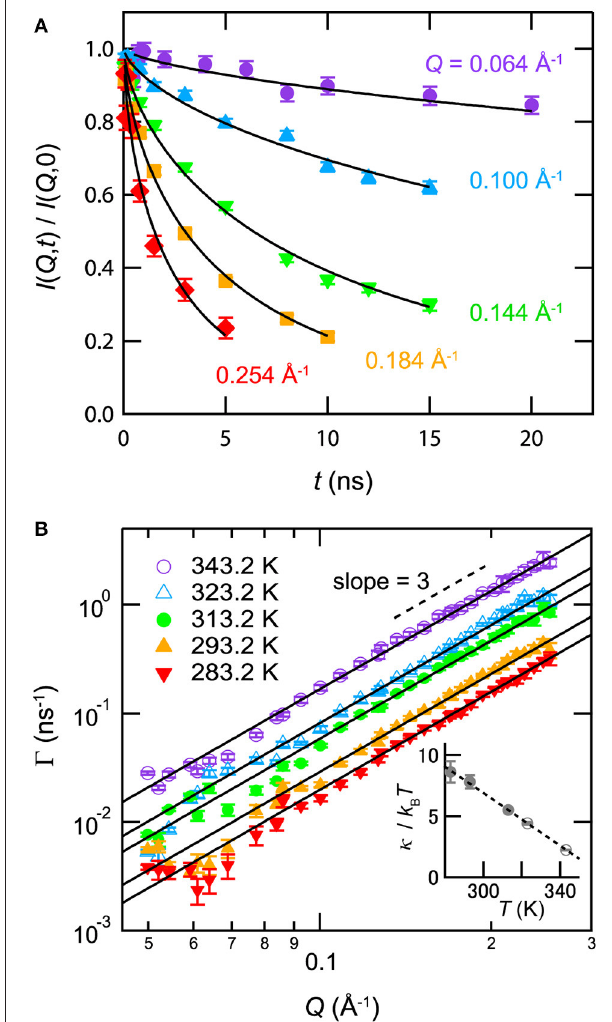
FIGURE 7 | (A) Normalized intermediate correlation functions I ( Q , t ) / I ( Q ,0) for the mixture of D 2 O/3MP/NaBPh 4 ( C salt = 85 mmol/L, φ 3MP = 0.09, and T = 293.2 K). The solid lines indicate fitting results according to Equation (7). (B) Q dependence of the relaxation rate Ŵ obtained from the fit of I ( Q , t ) / I ( Q ,0) according to Equation (7) for mixture of D 2 O/3MP/NaBPh 4 ( C salt = 85 mmol/L, φ 3MP = 0.09, and 283.2K ≤ T ≤ 343.2K). The closed and open symbols indicate data for the lamellar phase and the sponge phase, respectively. The solid lines are the fitting results according to Equation (8). The inset in (B) shows the temperature dependence of κ NSE / k B T according to Equation (8). The closed and open symbols indicate data for the lamellar phase and the sponge phase, respectively. The dashed line is a visual guide. Error bars denote ± 1 standard deviation. The figure is partly reproduced from Sadakane et al. [24] with permission from Copyright 2013 AIP Publishing